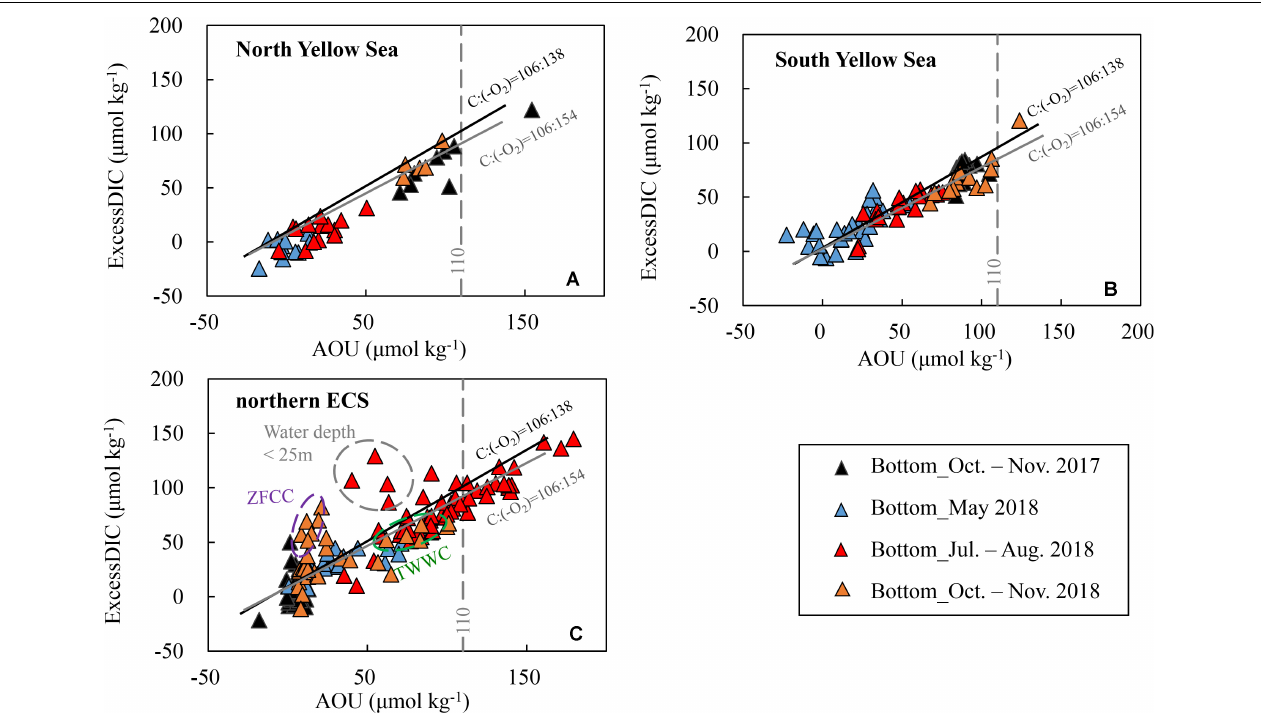
FIGURE 5 | Bottom-water excess dissolved inorganic carbon (ExcessDIC) versus apparent oxygen utilization (AOU) in late spring, summer and autumn. ExcessDIC was defined as the departure from the air-equilibrated DIC (corresponding to a mean atmospheric f CO 2 level of 415 ± 5 µ atm during our seasonal cruises in 2017–2018). The solid black line exhibits the traditional Redfield ratio, i.e., (cid:49) C: (cid:49) (–O 2 ) = 106:138 (Redfield et al., 1963), and the solid gray line indicates the more recent estimation of (cid:49) C: (cid:49) (–O 2 ) = 106:154 (Hedges et al., 2002). Plots of (A) the North Yellow Sea and (B) South Yellow Sea during summer and autumn are within the YSCWM. In panel (C) , several summer plots in the northern East China Sea (ECS) deviated from the Redfield line, as enclosed by gray dashed ellipse, are at shallow sampling sites with water depth of < 25 m. ZFCC = Zhejiang-Fujian Coastal Current in winter and early spring, while TWWC = TaiWan Warm